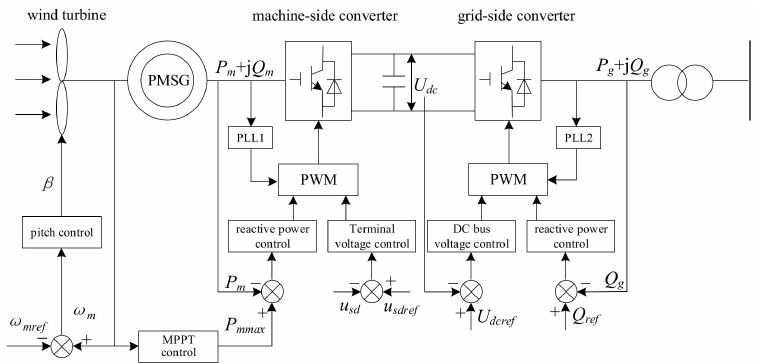
Figure 1. The basic structure of